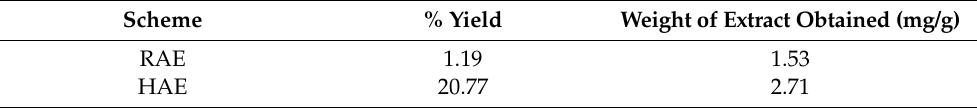
Table 1. Weight of extracts from MS samples.